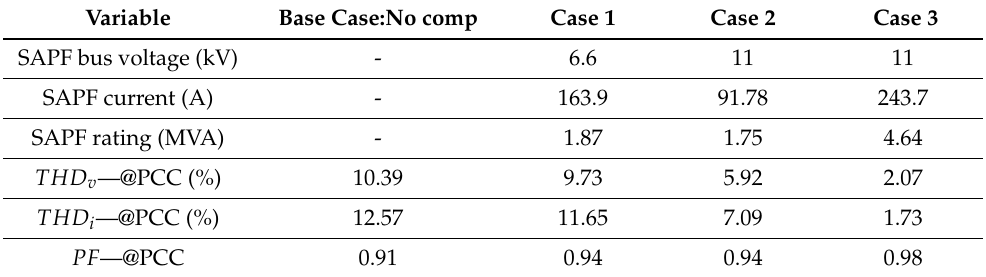
Table 6. Analysis of the power quality